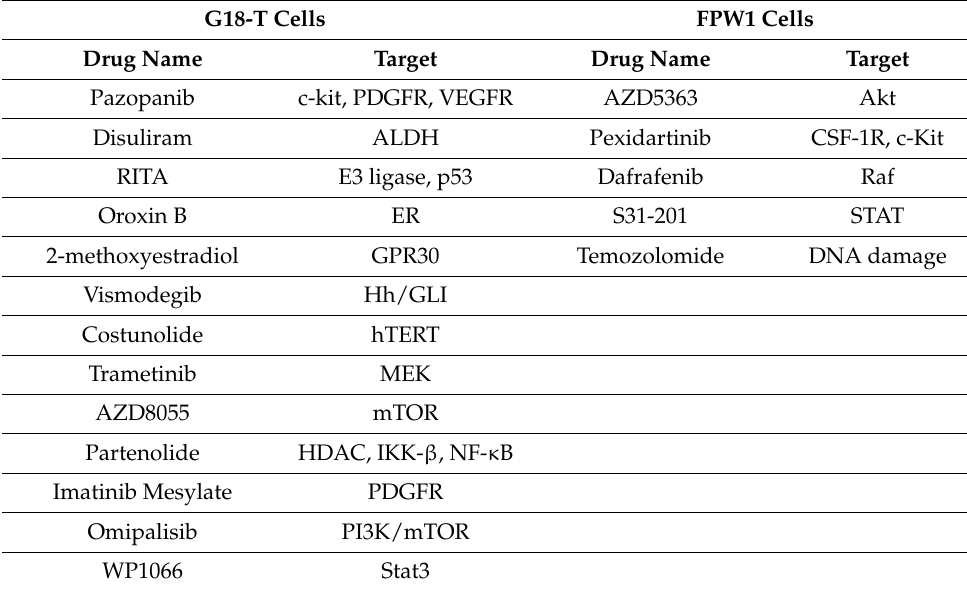
Table 3. Targets for “Group 3” drugs with selective effect in each cell